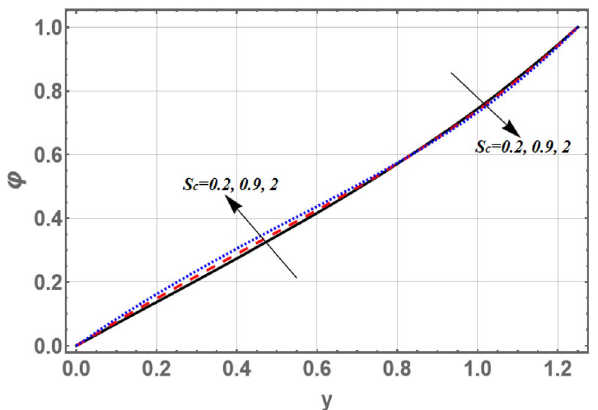
Figure 9. Graph of concentration ϕ for different values of Sc.